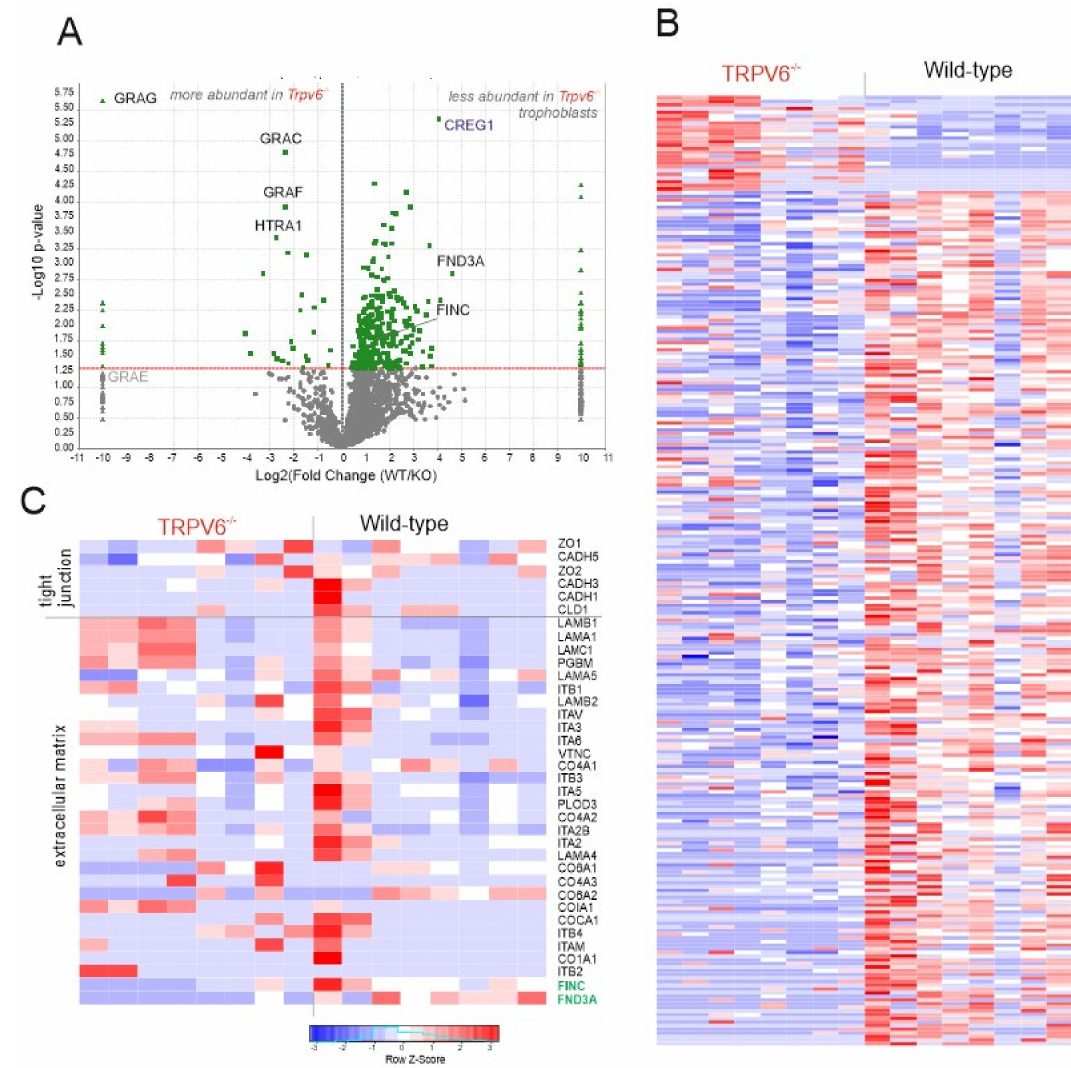
Figure4. Proteomeanalysisof wt and Trpv6 - / - trophoblasts. ( A )Vulcano-blot-reportingsemi-quantitative analysis of di ff erentially-expressed proteins identified by mass spectrometry in wild-type and Trpv6 - / - trophoblast lysates. Shown are 35 proteins upregulated and 314 proteins down-regulated in Trpv6 - / - compared to wild-type controls. Up- and down-regulated proteins were identified based on at least 2-fold changes in the exponentially-modified protein abundance index (emPAI) values with a p -value < 0.05, calculated using the unpaired two-tailed Student’s t -test. Proteins identified on the very left or the very right side of the blot ( − 10,10) were exclusively detected in Trpv6 - / - and wt trophoblasts, respectively. Fibronectin-domain-containing protein 3A (FND3A) and fibronectin (FINC) (green) and CREG1 (blue) were significantly more abundant in wt lysates. ( B ) Heatmap shows the Z-scores of the emPAI values from independent mass spectrometry measurements from eight independent wild-type and Trpv6 - / - samples. ( C ) Heatmap shows Z-scores for emPAI values of identified proteins detected in the gene ontology terms tight junctions and extracellular matrix / assembly. Fibronectin-domain-containing protein 3A (FND3A) and fibronectin (FINC) (green) were significantly more abundant in wt